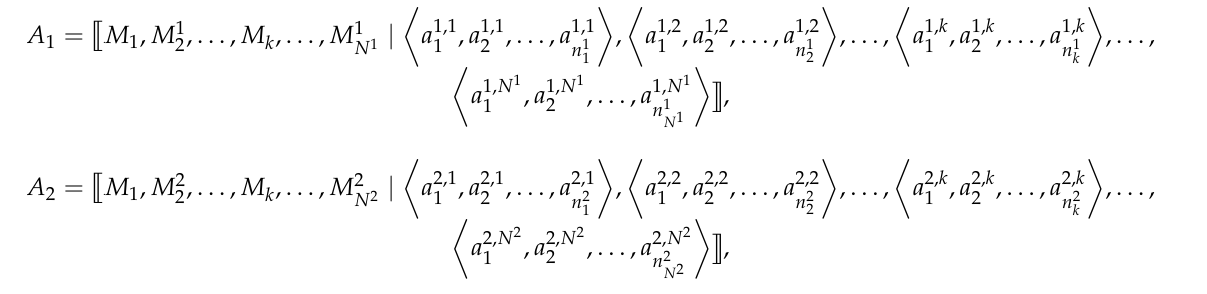
Figure 4. An example of two hiddenly compatible aggregates.